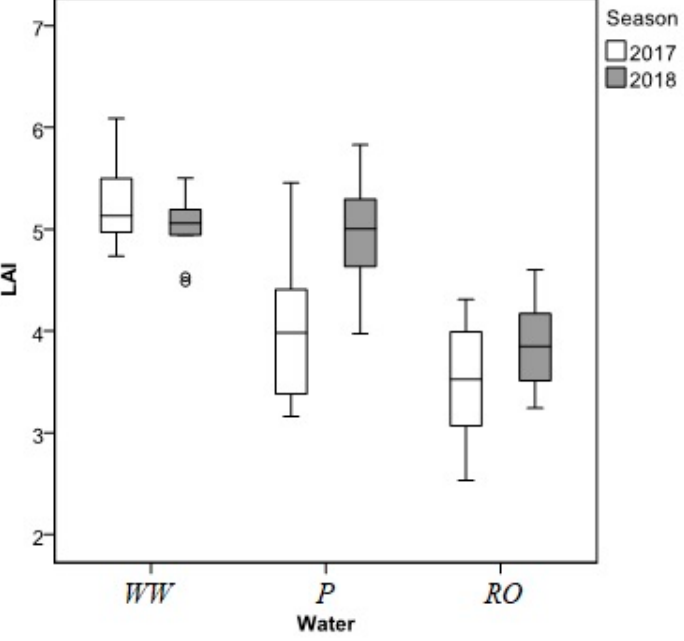
Figure 4. Seasonal mean leaf area index ( LAI ) boxplots that highlight the water-season interaction during the 2017 and 2018 growing seasons.